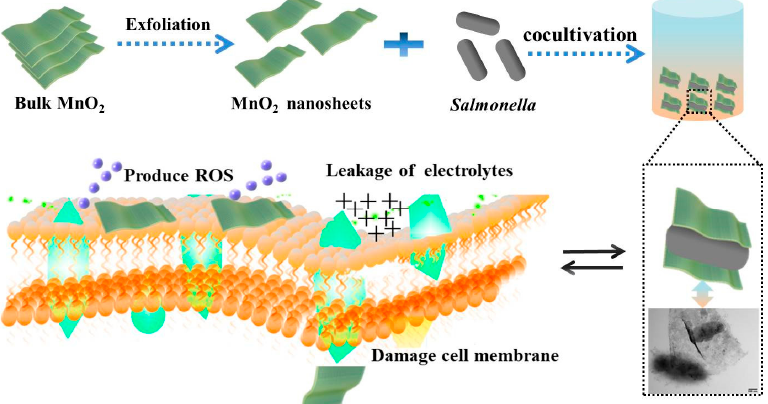
Figure 9. Measurement of total electrolytes of Salmonella after exposure to different concentrations of MnO 2 nanosheets ( A ). Measurement of total ATPase activity ( B ) and protein contents ( C ) of Salmonella after exposure to 125 μ g/mL MnO 2 nanosheets. Statistical significance was decided with a * p < 0.05 and ** p <